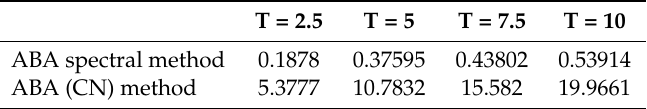
Table 9. Computational errors of two solitons in spinor system.